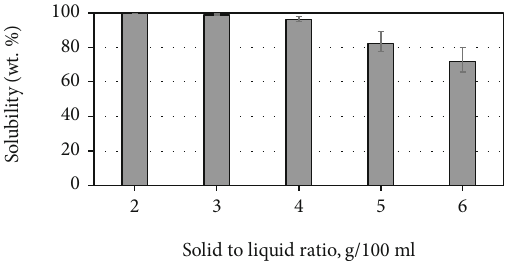
Figure 7: The e ff ect of solid to liquid